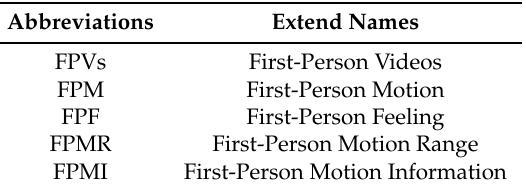
Table 1. Concept